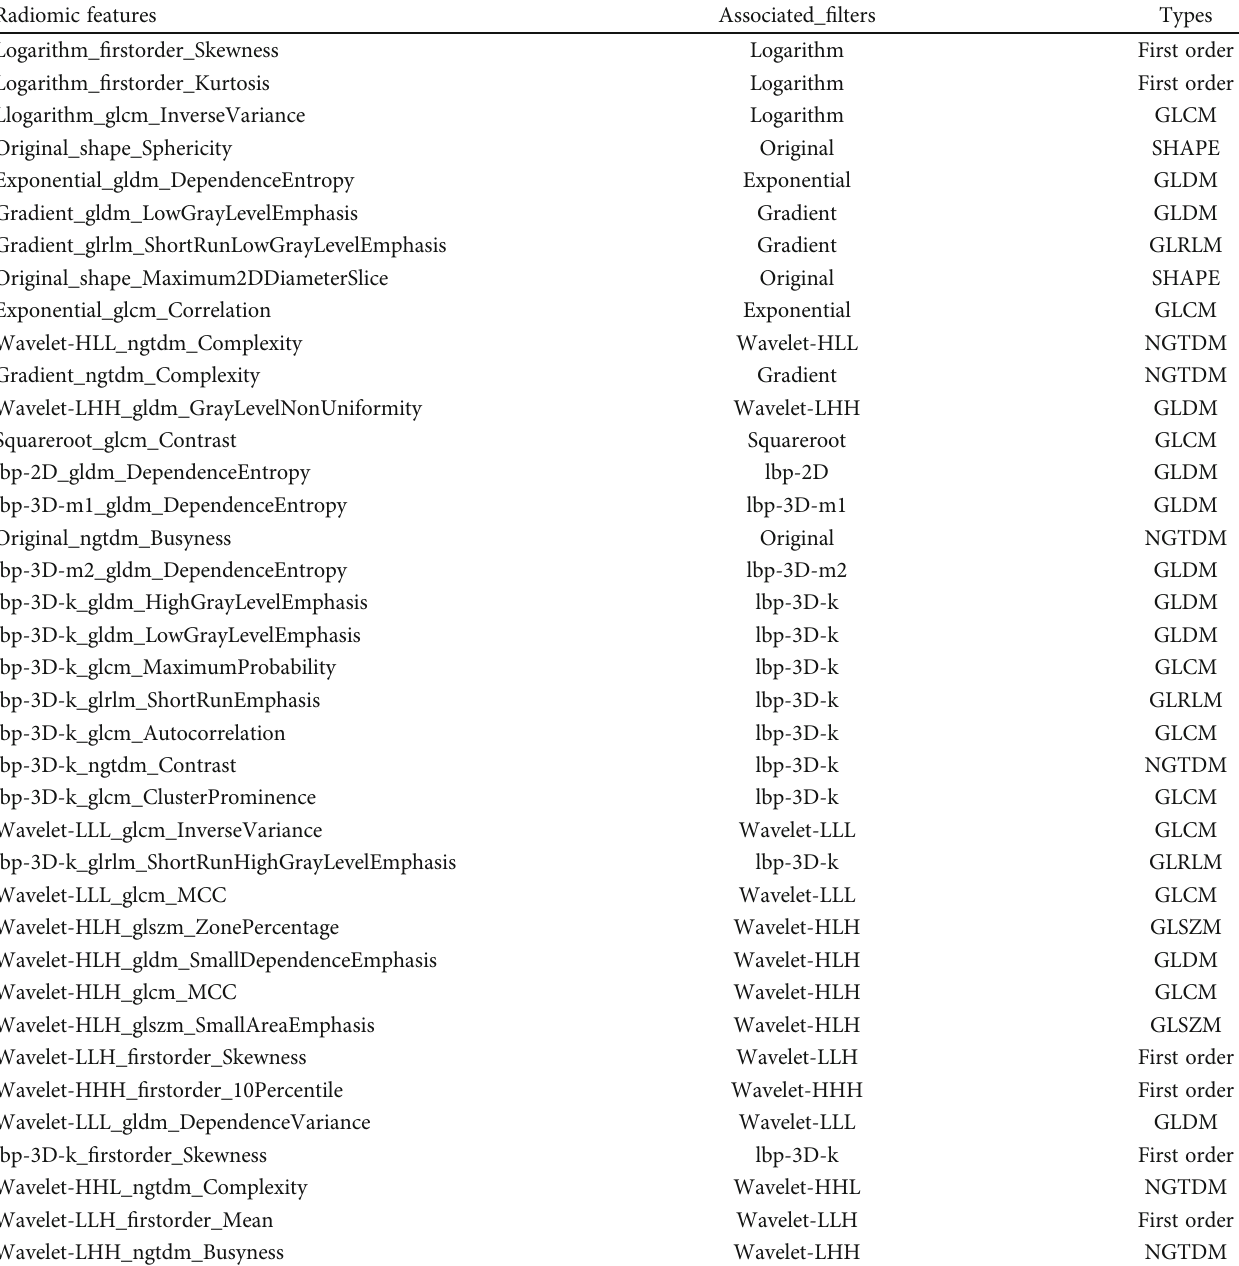
Table 1: Description of the selected radiomic features and their associated feature types and fi lters. Radiomic